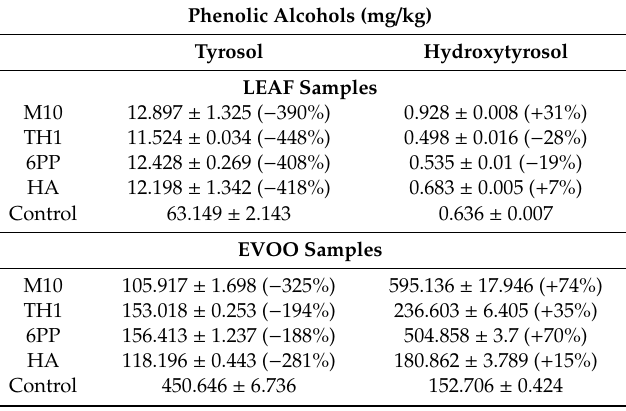
Table 4. Phenolic alcohol compounds in the leaf and the EVOO